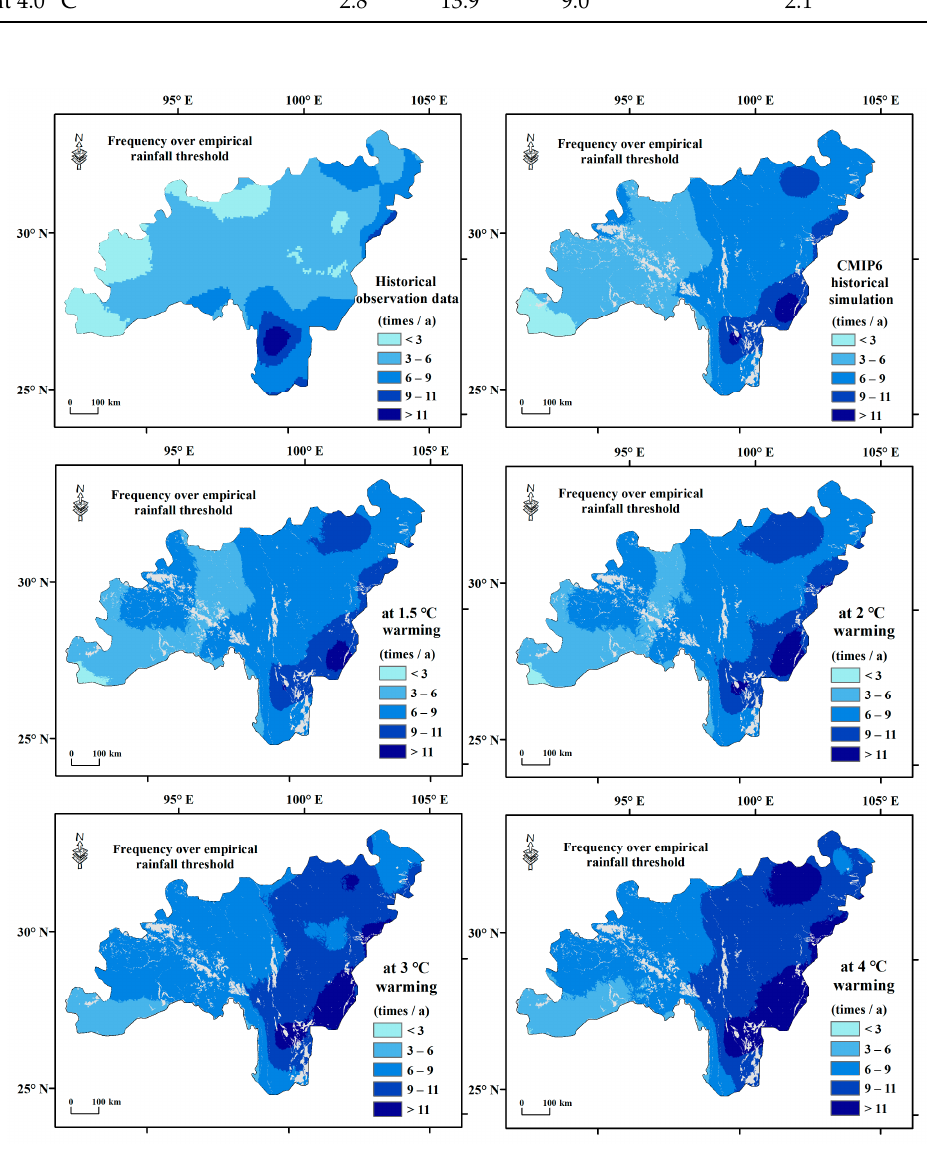
Figure 7. Frequency over empirical rainfall threshold (FOERT): based on the historical observation, the CMIP6 historical simulation, as well as the future projection under 1.5–4.0 ° C warming scenarios.